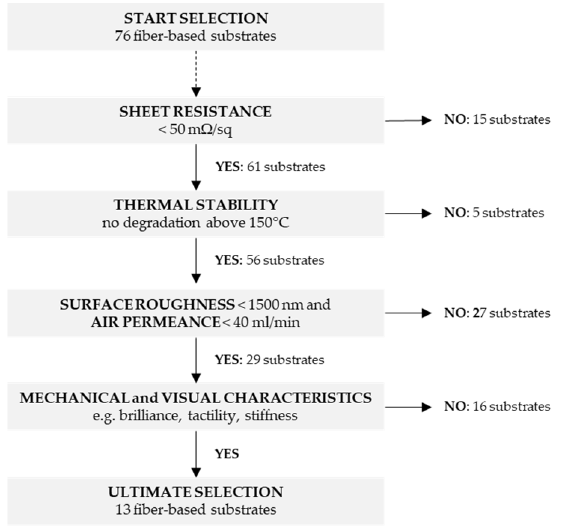
Figure 8. Elimination criteria with threshold values used to downscale the number of fiber-based test substrates towards a selection of substrates with suitable properties for printed electronics. Table 1. Ultimate selection of fiber-based substrates, compatible with printed